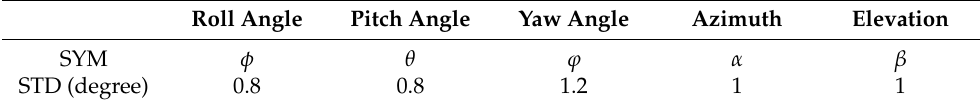
Table 1. Measurement noise